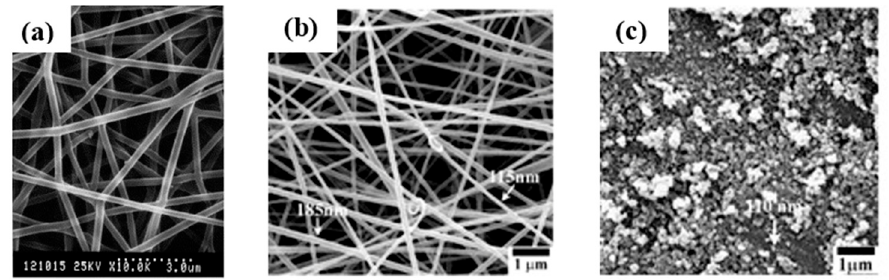
Figure 2. Fabrication of oxide nanoparticles (NPs) by electrospinning: ( a ) Scanning electron microscopy photographs of various polyvinyl alcohol (PVA) / silica fibers with silica content of 22wt% [48], copyright 2003 Elsevier Ltd; ( b ) scanning electron microscopy images of zinc acetate (Zn(OAc) 2 ) / cellulose acetate (CA) composite nanofibers containing 10wt% Zn(OAc) 2 ; ( c ) NPs from calcination of (a) in air at 500 °C for 5 h [49], copyright 2008 American Chemical Society.